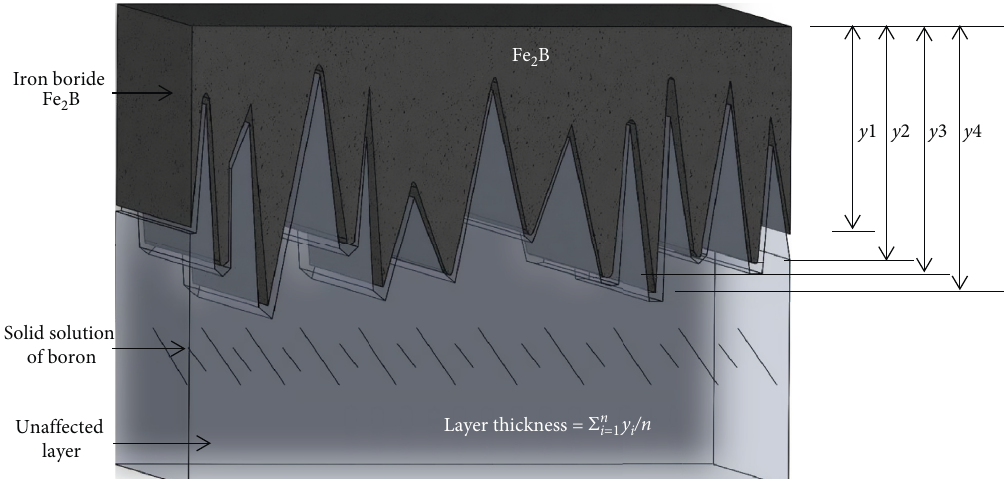
Figure 4: A schematic diagram illustrating the procedure for estimation of boride layer thickness in ASTM A36 steel [3, 5].